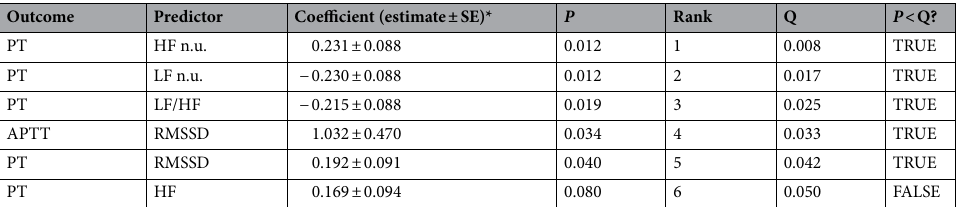
Table 3. Results of linear regression models (adjusted for age and BMI). SE standard error, PT prothrombin time, APTT activated partial thromboplastin time, RMSSD the root mean square of successive heartbeat interval differences, HF high-frequency power, LF n.u. low-frequency power in normalized units, HF n.u. high-frequency power in normalized units, LF/HF the ratio of low-frequency power to high-frequency power. *Effects for a 1 − SD increase in the predictor adjusted for covariates. Q: the Benjamini–Hochberg critical value [= (rank/number of tests) × FDR]. TRUE for P < Q indicates statistical significance after correcting for the FDR.